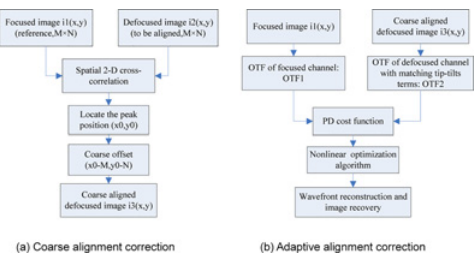
Fig 1. Flowchart of the proposed alignment correction algorithm.